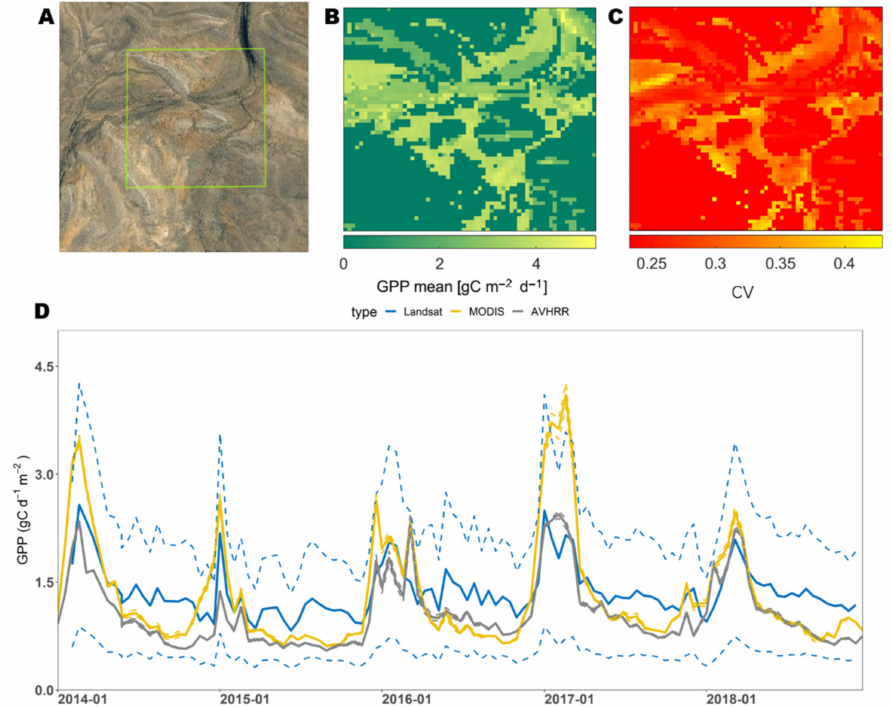
Figure 6. A savanna ecosystem near Gregory, Queensland, Australia (139.34 E, 18.89 S). The research region is in the green box of subplot ( A ). Subplots ( B , C ) show the mean GPP and seasonal change in GPP at each pixel from 2014 to 2018, respectively. Subplot ( D ) shows the seasonal change in GPP L , GPP M , and GPP A , while the dashed curves represent the ± 1 standard deviation of GPP in the entire research region in each series.